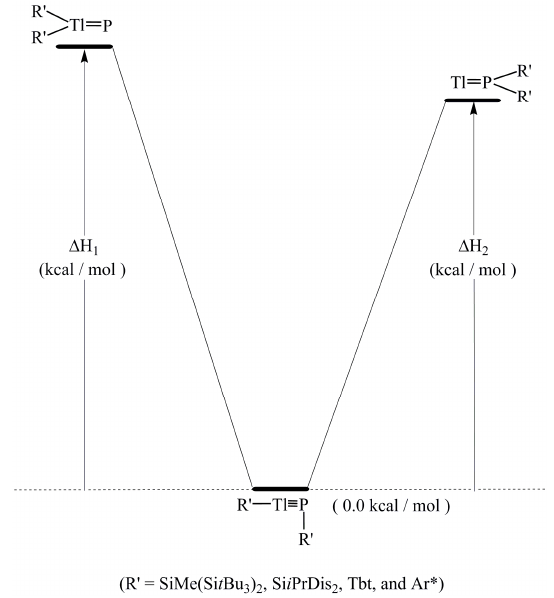
Figure 4. The potential energy surface for the 1,2-migration reaction of the R ′ Tl ≡ PR ′ molecules with balky groups (R ′ ).